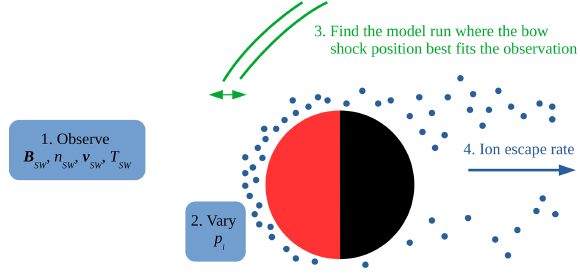
Figure 1. An illustration of the algorithm to estimate the ion escape rate. The Sun is to the left, and Mars is the red and black disk. Us- ing fixed upstream solar wind conditions from observations in the hybrid model, we vary the ionospheric heavy-ion (blue dots) pro- duction rate for different simulation runs. The bow shock location (green lines) in each simulation run is then compared to the ob- served bow shock location. The estimated escape rate corresponds to that of the simulation run that best fits the bow shock